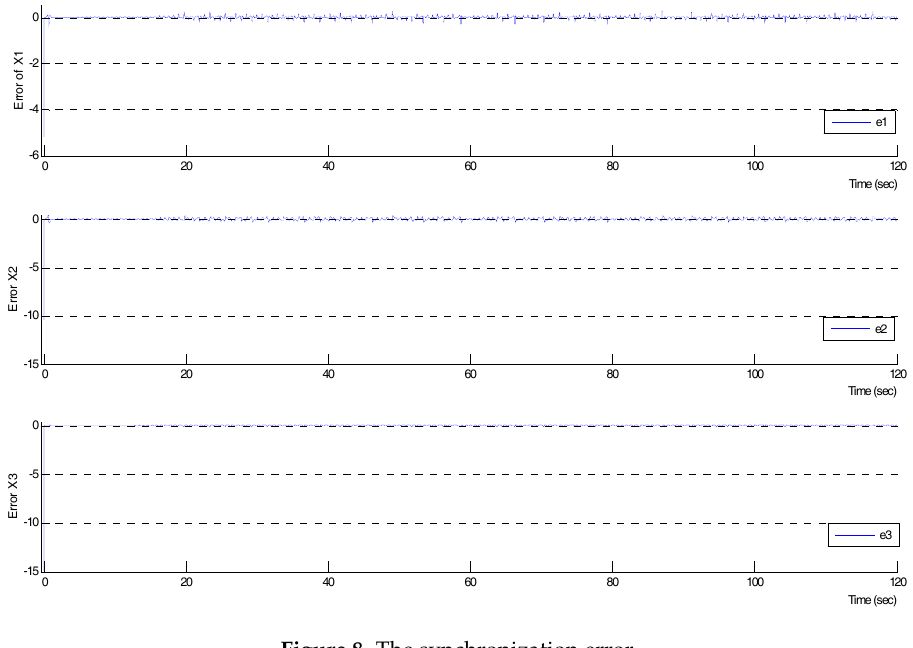
Figure 8. The synchronization error.